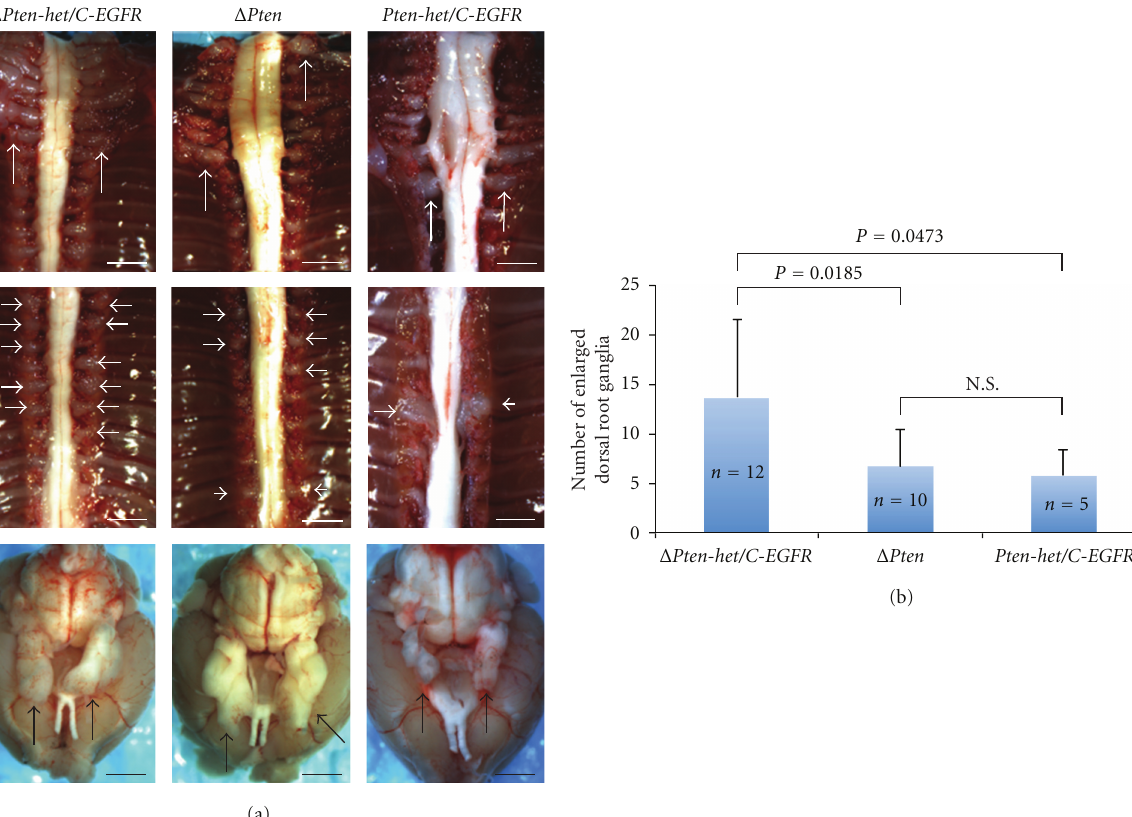
Hyperplasia/Low 100% 100% 80% 20%